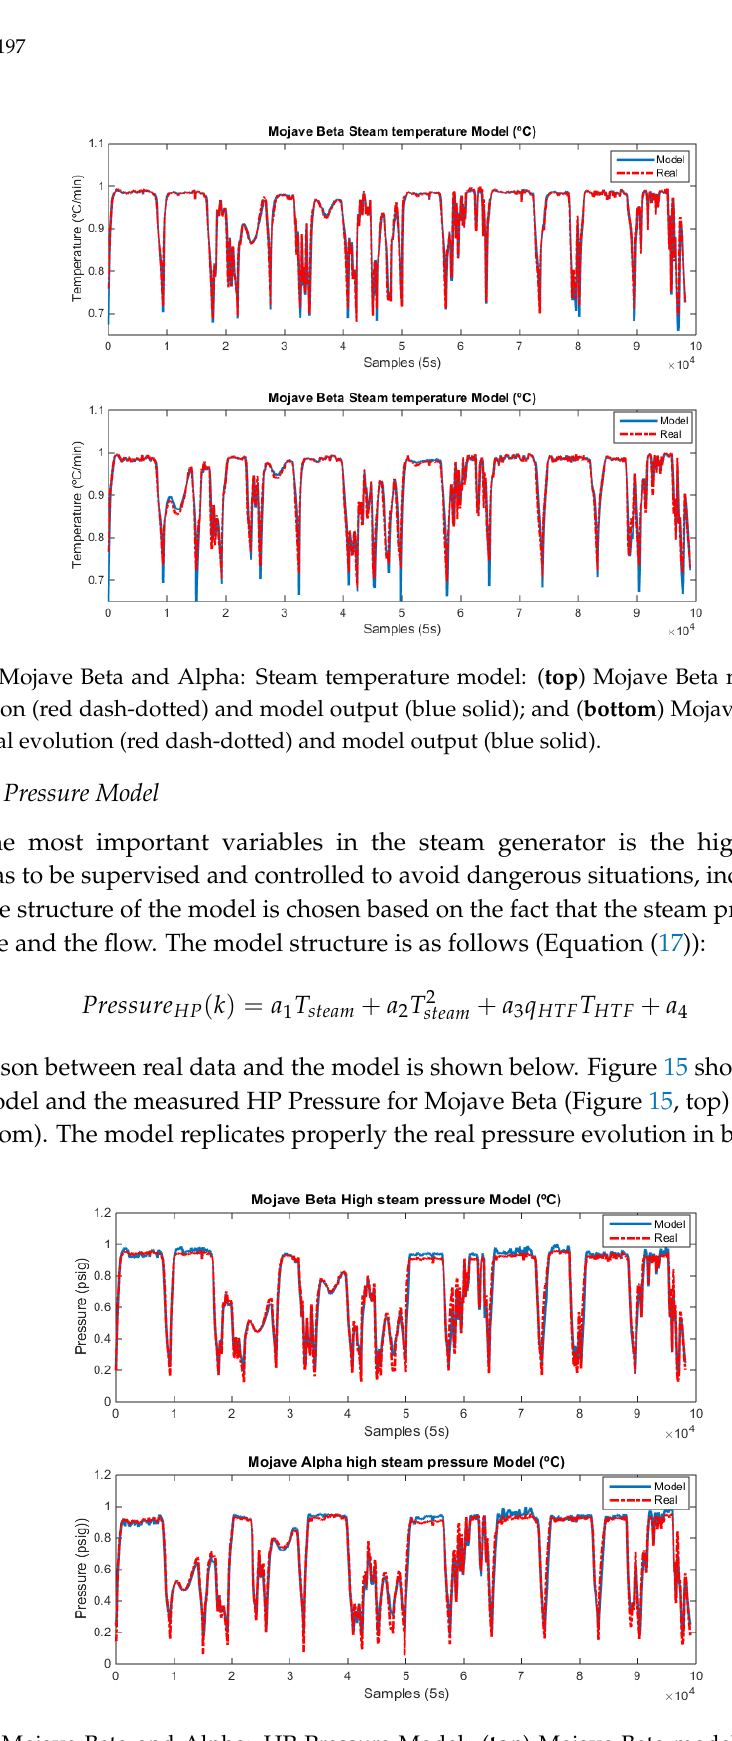
Figure 15. Mojave Beta and Alpha: HP Pressure Model: ( top ) Mojave Beta model, showing real evolution (red dash-dotted) and model output (blue solid); and ( bottom ) Mojave Alpha model, showing real evolution (red dash-dotted) and model output (blue